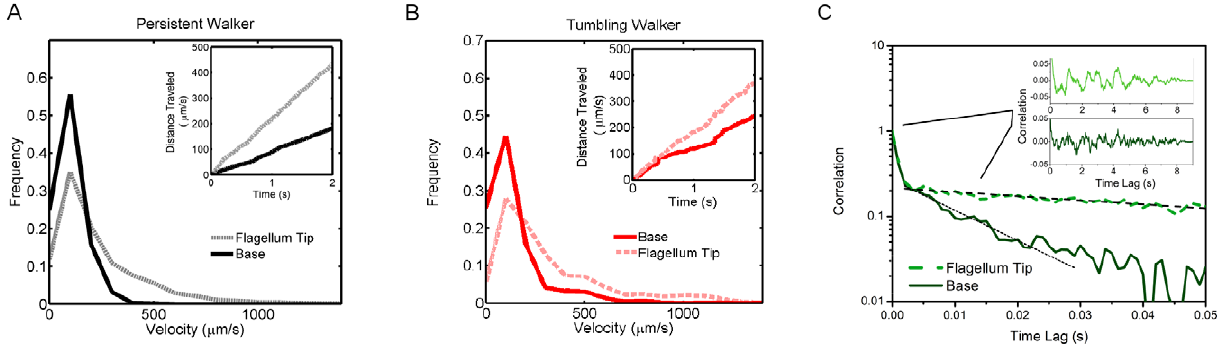
Figure 6. Velocity and correlations in cell-end movements. Typical velocity distributions for (a) Persistent walkers and (b) Tumbling walkers (shown relative to center of mass), insets are distance traveled vs time for typical individuals - the mean slopes were used to calculate cell-end velocities listed in the text. In both swimming modes, the tip moves much faster than the base. (c) Typical velocity autocorrelation of cell ends. Both persistent and tumbling walkers exhibit a faster decay in velocity autocorrelation for the base than the flagellum tip (exponential fit - dashed black line). Inset: linear plot of correlation, shows a periodicity in velocity at * 1 : 2 s .